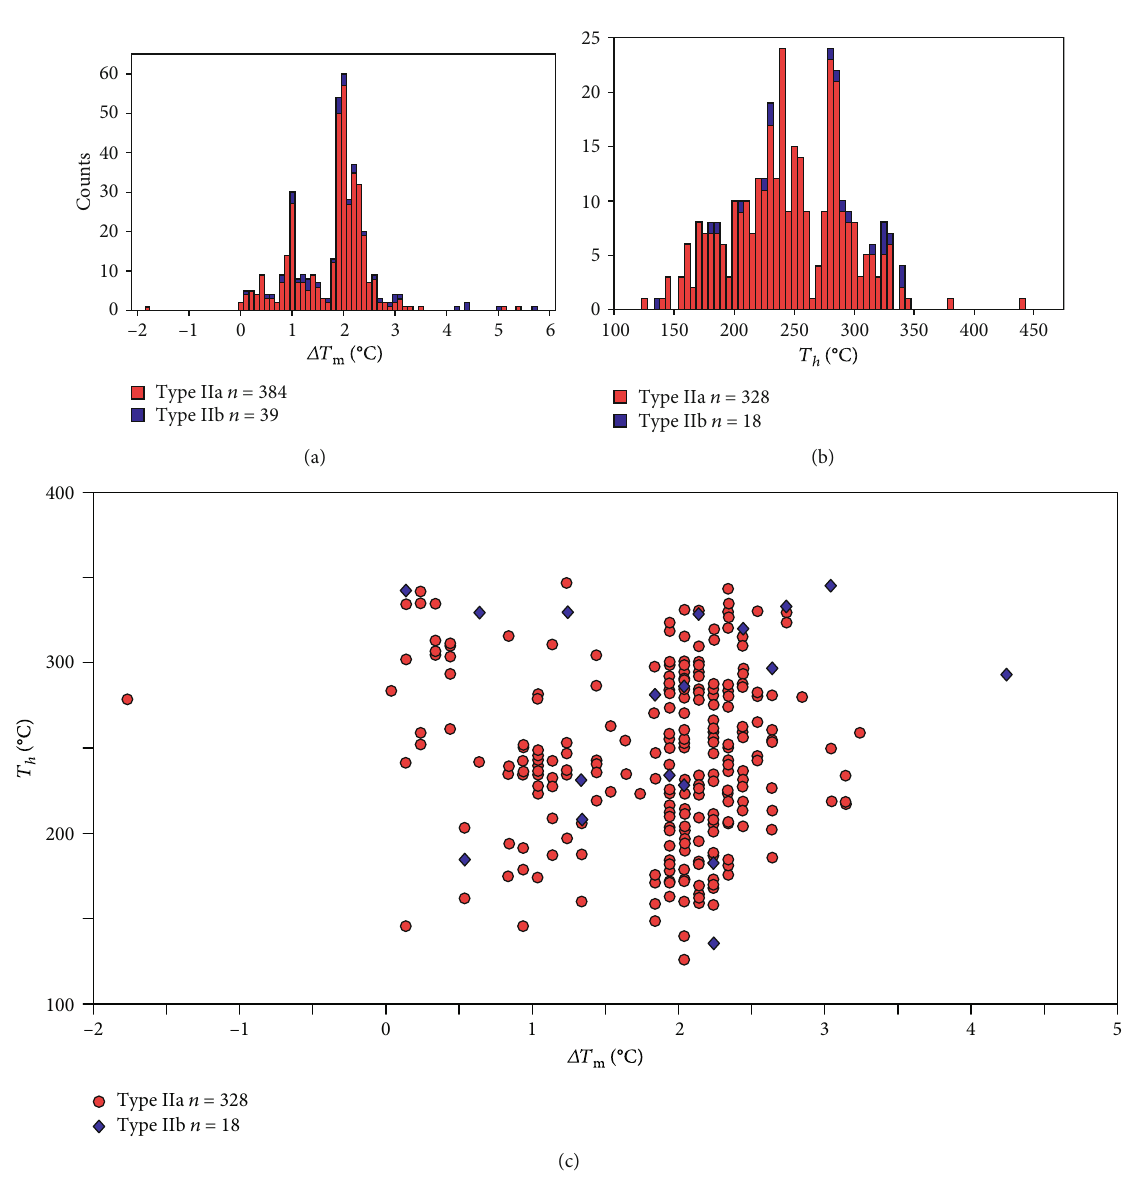
Figure 4: Microthermometric raw data plotted by inclusion types. Type IIa inclusions are shown in red, and Type IIb inclusions shown in blue. (a) Histogram of measured ice-melting temperatures expressed as the melting point depression ( Δ T homogenization temperature ( T ). (c) Δ T vs. T for inclusions where both parameters are h m h